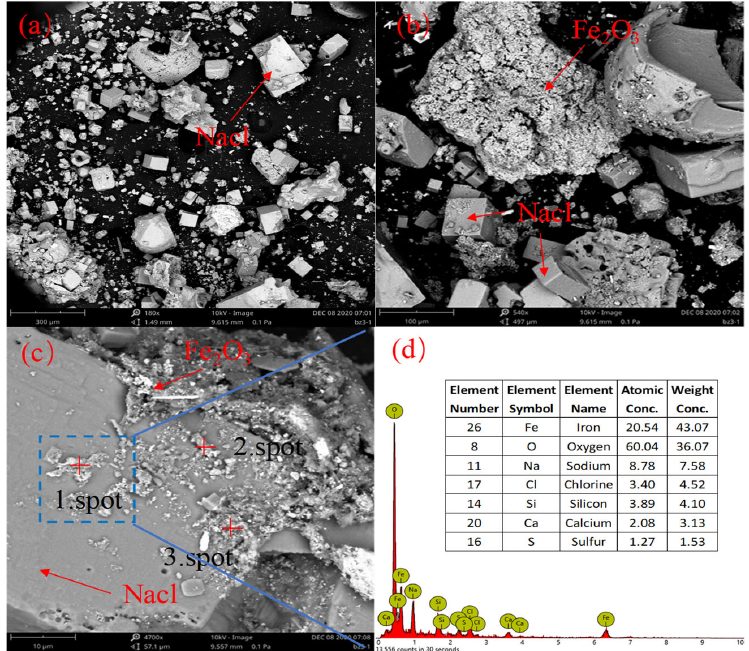
Figure 5. Scanning electron micrograph and energy spectrum analysis of unknown mixture